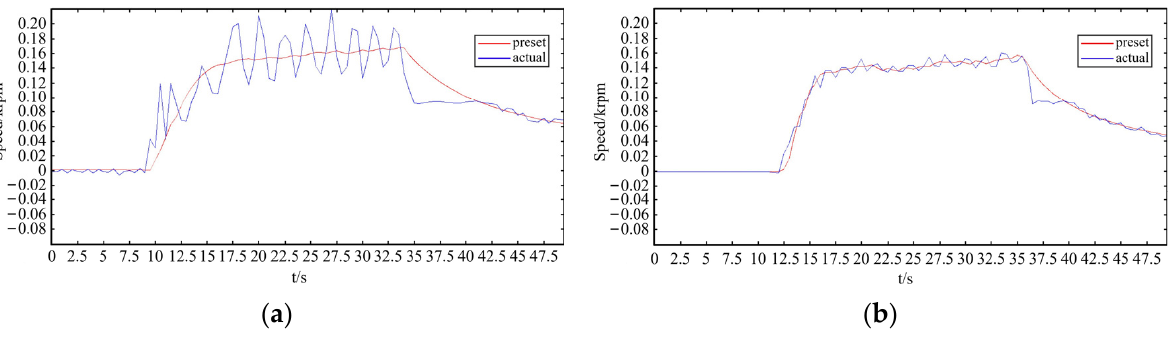
Figure 9. ( a ) The preset speed of the bearing motor and the actual speed of the loading motor before the application of this method. ( b ) The preset speed of the bearing motor and the actual speed of the loading motor after the application of this method.